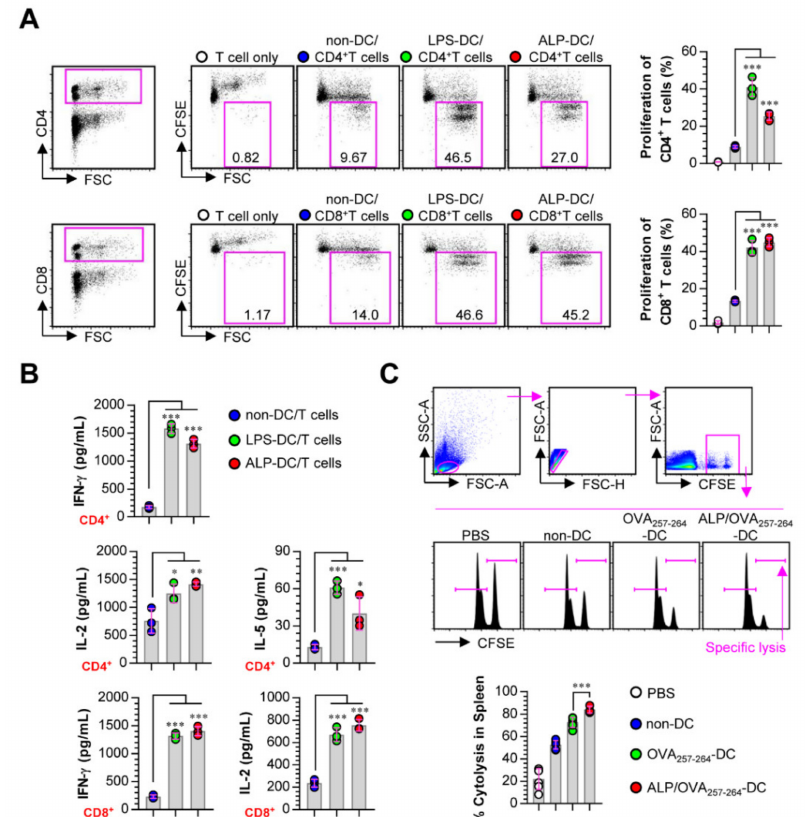
Figure 4. ALP-treated DCs initiate T cell proliferation and the Th1 response and enhance cytotoxic T lymphocyte(CTL)activity. ( A )ALP(200 µ g /